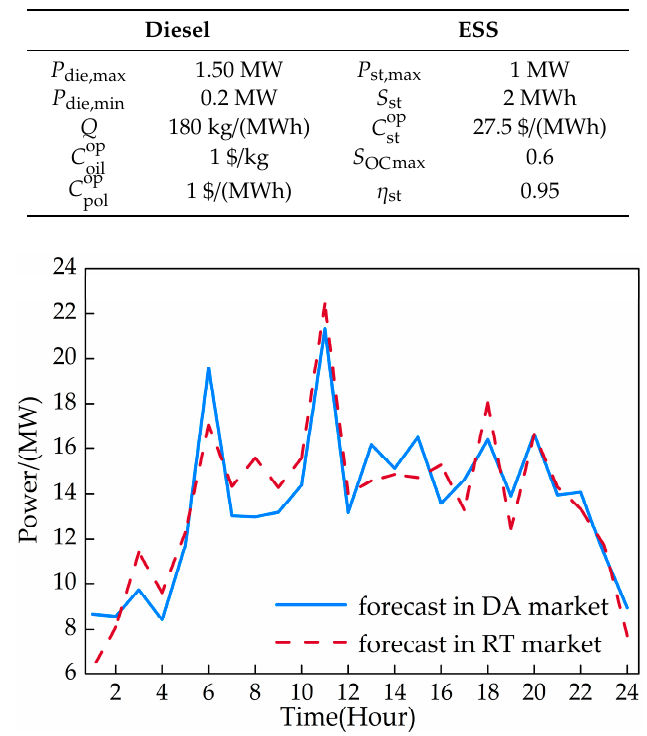
Figure 6. Forecasting outputs of wind/solar/load in the DA and RT market.